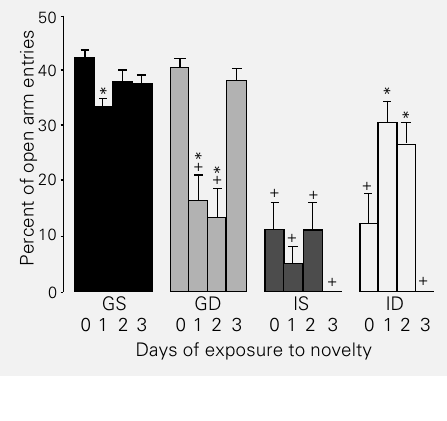
Figure 3 - Time (mean ± SEM) spent in the open arms. GS, Rats grouped in the same vivarium; GD, rats grouped in different vi- varia; IS, rats isolated in the same vivarium; ID, rats isolated in different vivaria. *P<0.05 com- pared to the corresponding 0-day exposed group; + P<0.05 com- pared to the corresponding GS group (Dunnett multiple com- parisons